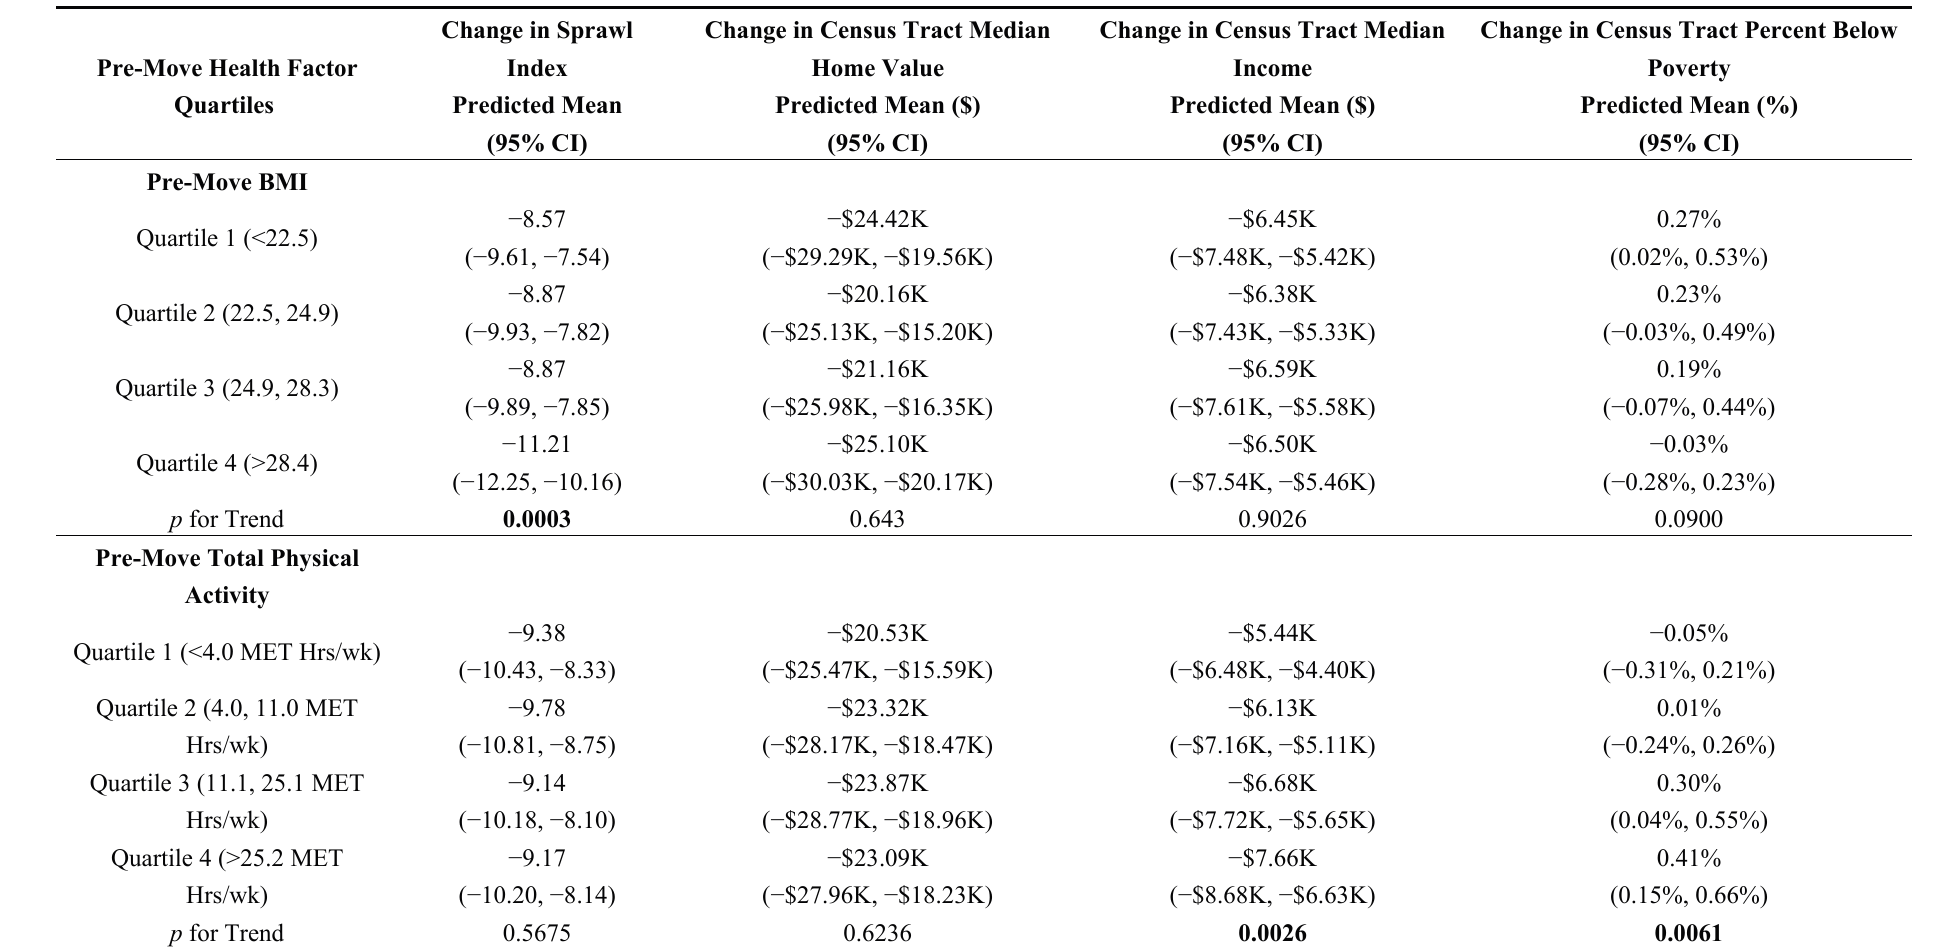
Table 3. Age-adjusted predicted mean change in neighborhood environment based on pre-move health factors in nurses’ health study participants (n = 14,159 participants) a